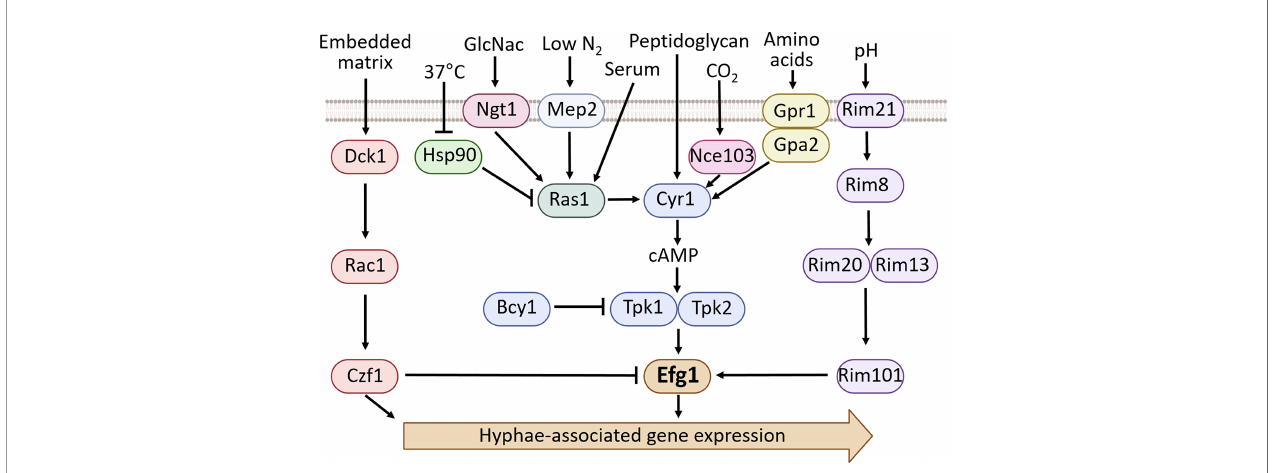
FIGURE 1 | An overview of the environmental cues and factors that regulate hyphae formation in C. albicans , focusing on the signaling pathways involving Efg1 (Sudbery, 2011; Noble et al., 2017; Chen et al.,